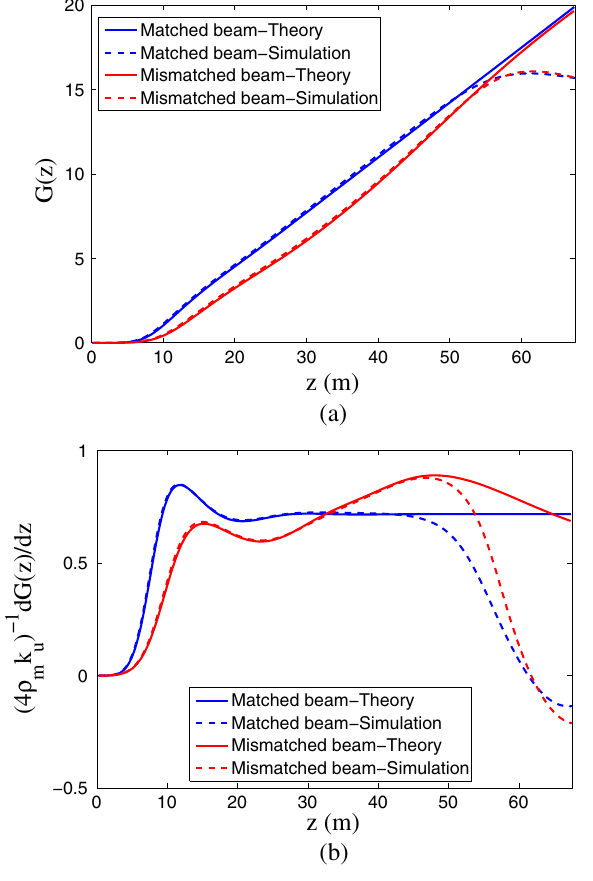
(cid:2) and FIG. 11. (a) Radiation and (b) electron beam sizes in units of 0 (cid:9) Þ (cid:1) 1 dG ð z Þ =dz for a matched and a mismatched electron beam. The legend k m m u is the same as in Fig. 10.